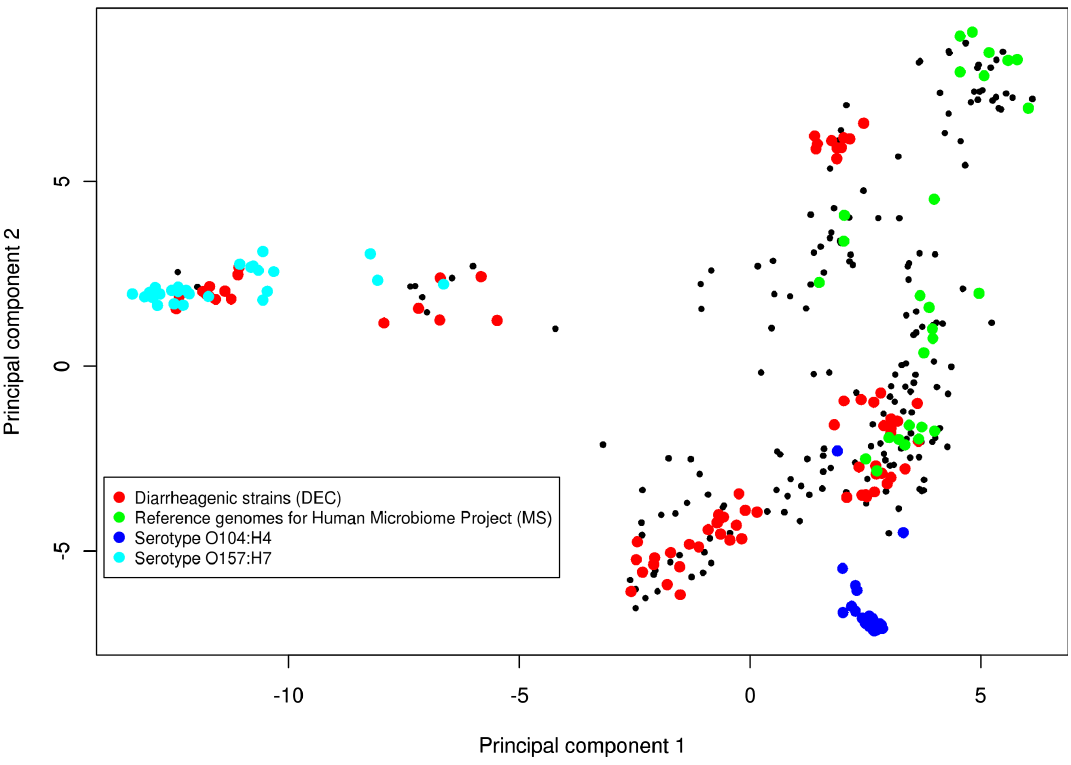
Figure 6. Genomes in functional space. Each dot corresponds to a genome plotted in the two first principal component directions of the E. coli functional space defined by the presence/absence of domain sequence families. There are four large subsets of genomes in the data set, and these dots are marked with colors, see figure legend. The first principal component accounts for 11% of the total data variation, and the second component 8%. Only relative positions of the genomes (dots) are important, the absolute scores on each axis lacks